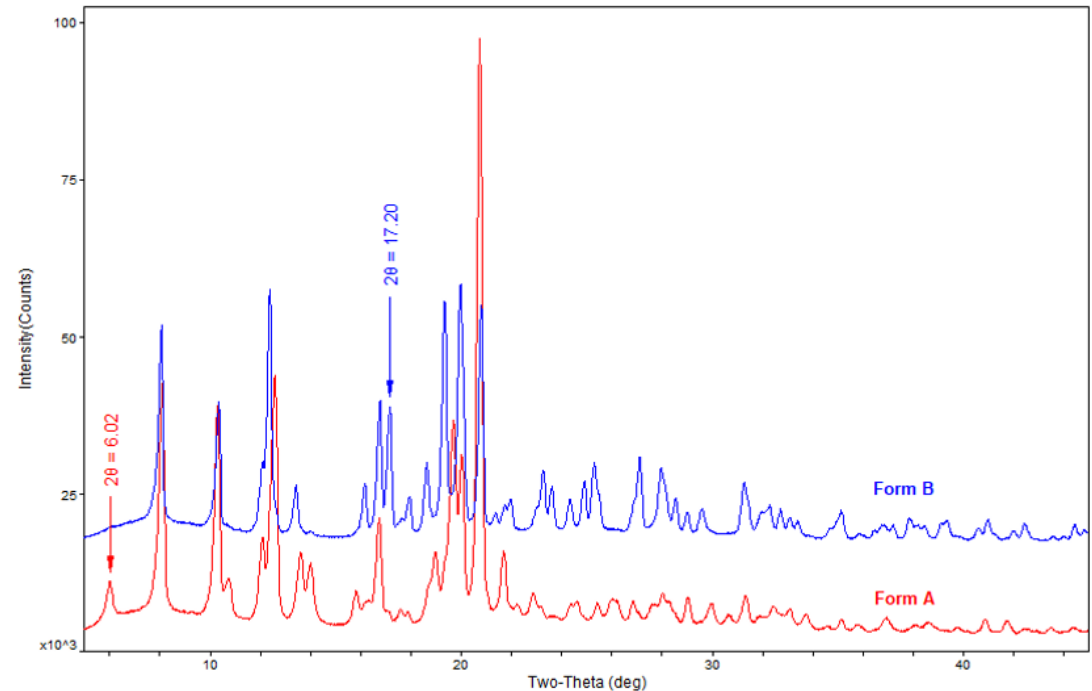
Figure 2. Powder X-ray diffraction (PXRD) patterns of sofosbuvir of form A and form B .